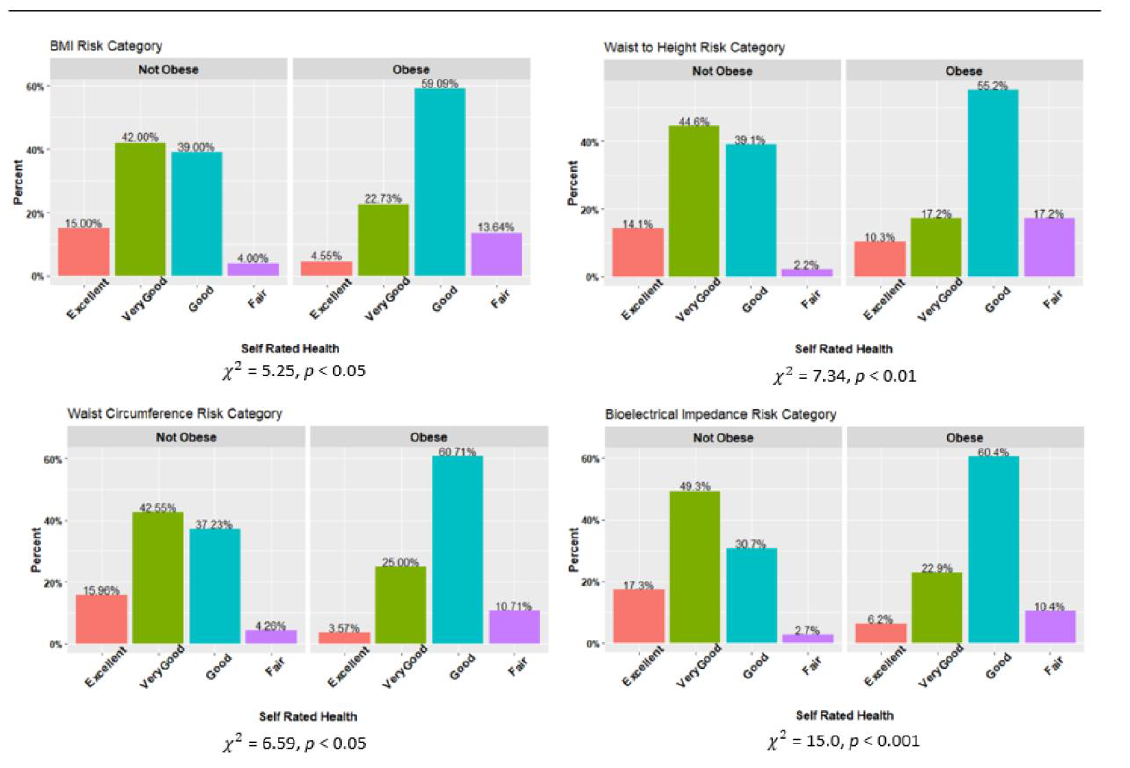
Figure 3. Body composition risk categories and self-rated health. Note: Chi square analyses based on dichotomizing Self Rated Health as Excellent/Very Good vs. Good/Fair.